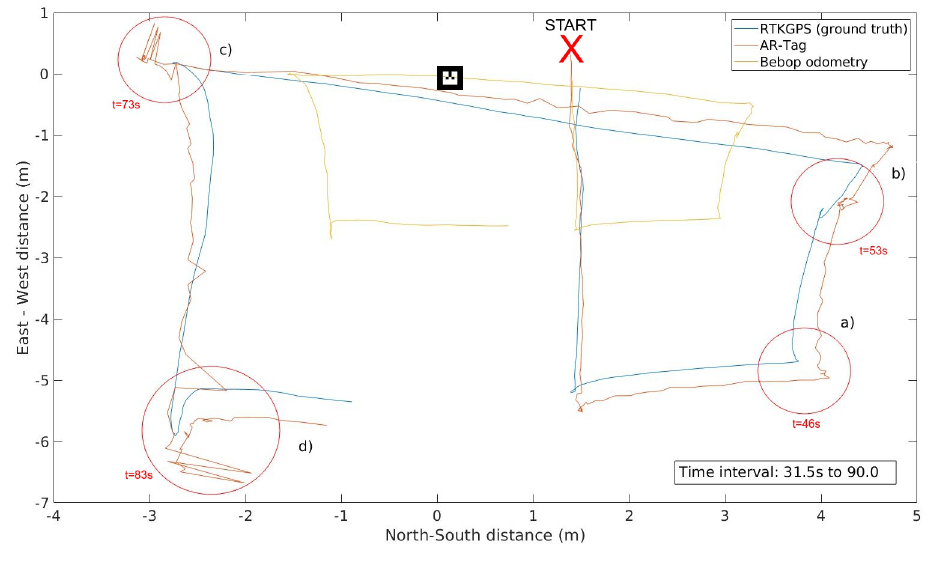
Figure 9. UAV flight path comparing the AR-Tag error with the Bebop odometry error. The blue, red, and yellow lines represent the ground truth, AR-Tag position, and Bebop drone odometry data, respectively. Compared with the odometry data, the AR-Tag presents significantly